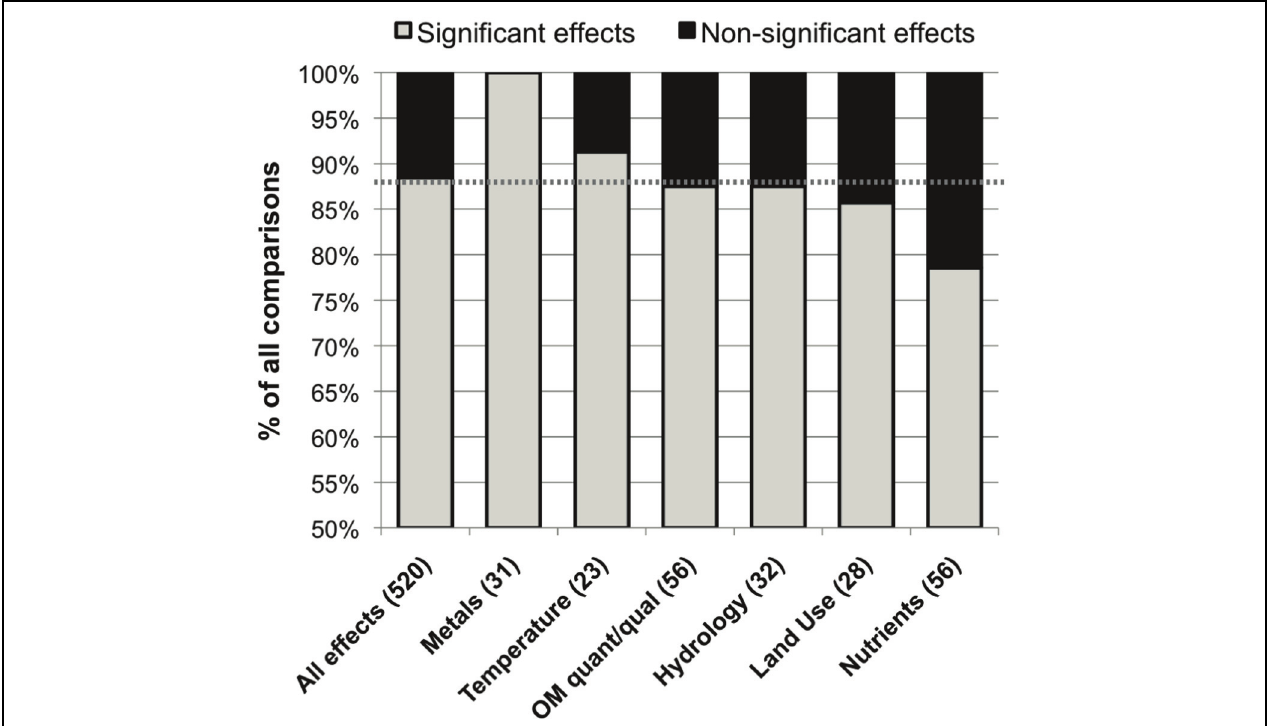
FIGURE 5 | Distribution of significant (in gray) and non-significant (in black) reported effects of categories of variation in defined environmental drivers on stream microbial diversity, with number of included studies noted for each category along the x-axis, and the percentage of significant effects for all comparisons combined noted as a dashed line for